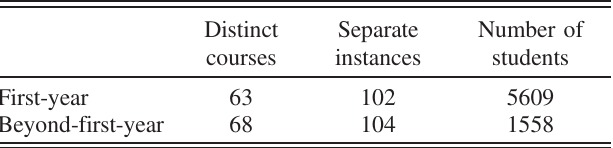
TABLE II. Number of first-year and beyond-first-year courses in the matched data set. The number of students in the beyond- first-year courses is smaller in part because of the smaller class sizes typical of more advanced physics labs. The number of separate instances of the E-CLASS accounts for courses that administered E-CLASS more than once in the 7 semesters of data